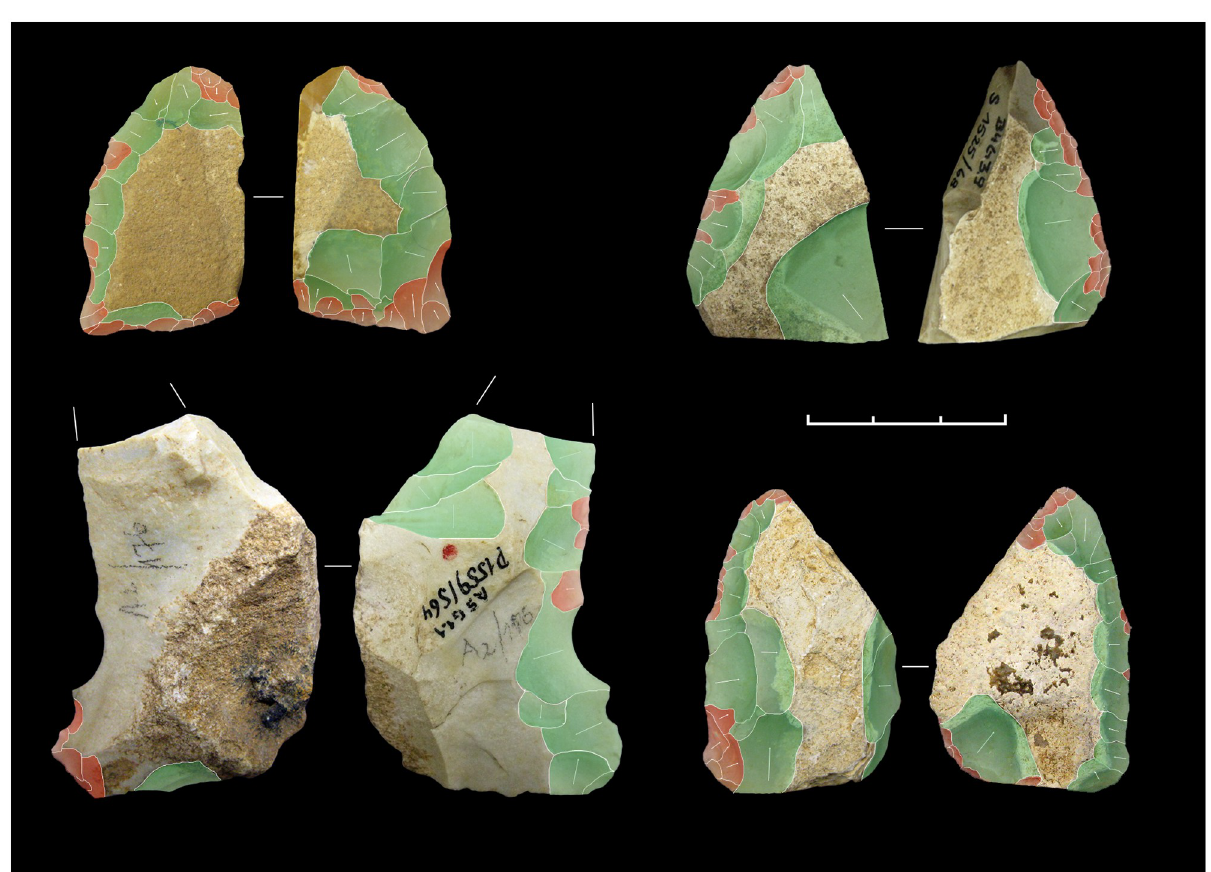
Fig 19. Keilmesser blank-tools, that is the blanks shaped with the only function of manufacturing an asymmetrical backed bifacial tool. In green, the detachments aimed to first tool shaping; in red, edge refining. From the top left: S2221/68; S1525/68; P1559/S64; S310/74.